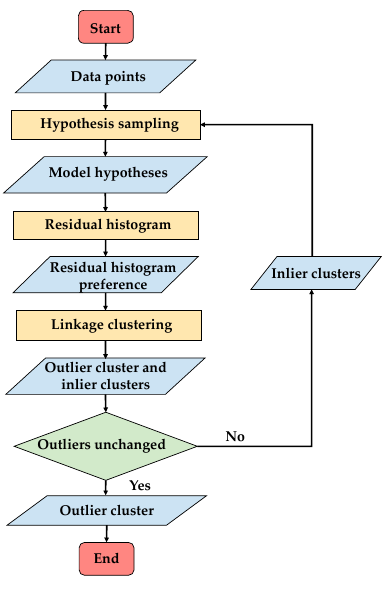
Figure 4. The flowchart of outlier detection.